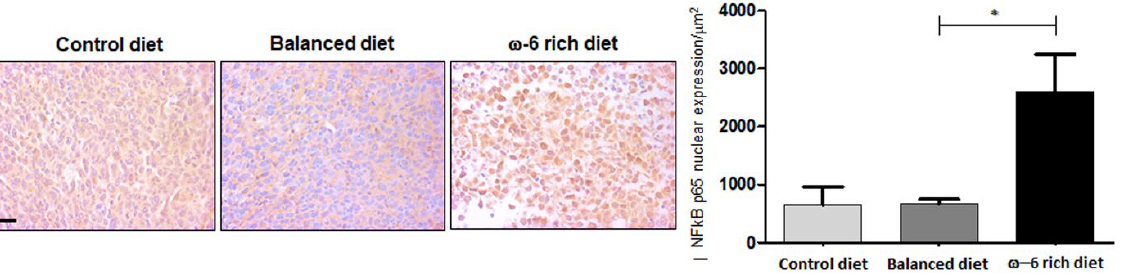
Figure 6. High intake of ω -6 PUFA induces nuclear expression of NF- κ B p65. Analysis of p65 expression. Groups: control diet, balanced diet and diet rich in ω -6. Representative photomicrographs of NFκB p65 expression are shown on the left. On the right side, the quantification of the stains can be seen; the data are expressed as the mean + SEM, n = 5, * p < 0.05. Scale bar: 20 μm.